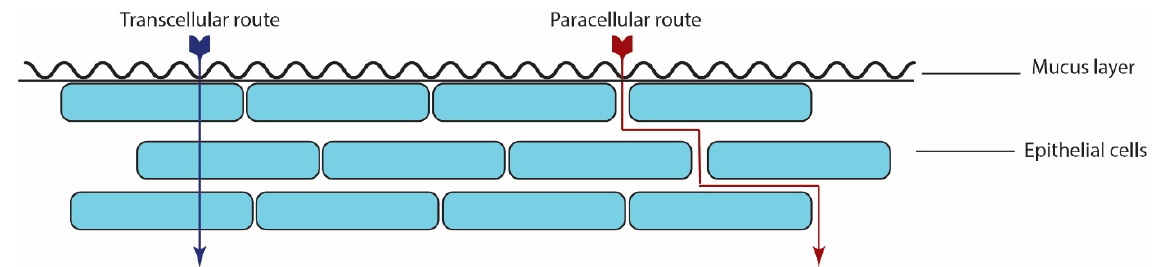
Figure 2. Transport pathways in the oral mucosa.